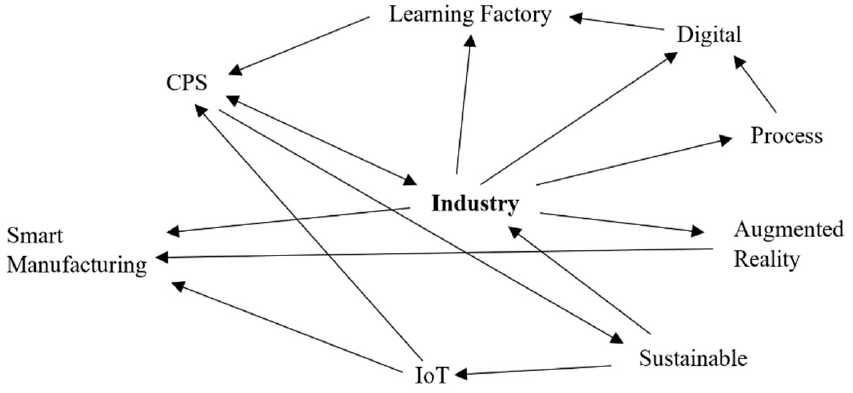
Figure 5. Analysis and relationship of the keywords. Other authors have done comparable bibliographic analysis on Industry 4.0. Li et al. analyzed individual keyword frequency and the focus of research in literature [130]. The combination of individual words was not considered as well as similar spellings or thematic duplicates (Internet of Things/IoT), but there have been the same results as in the